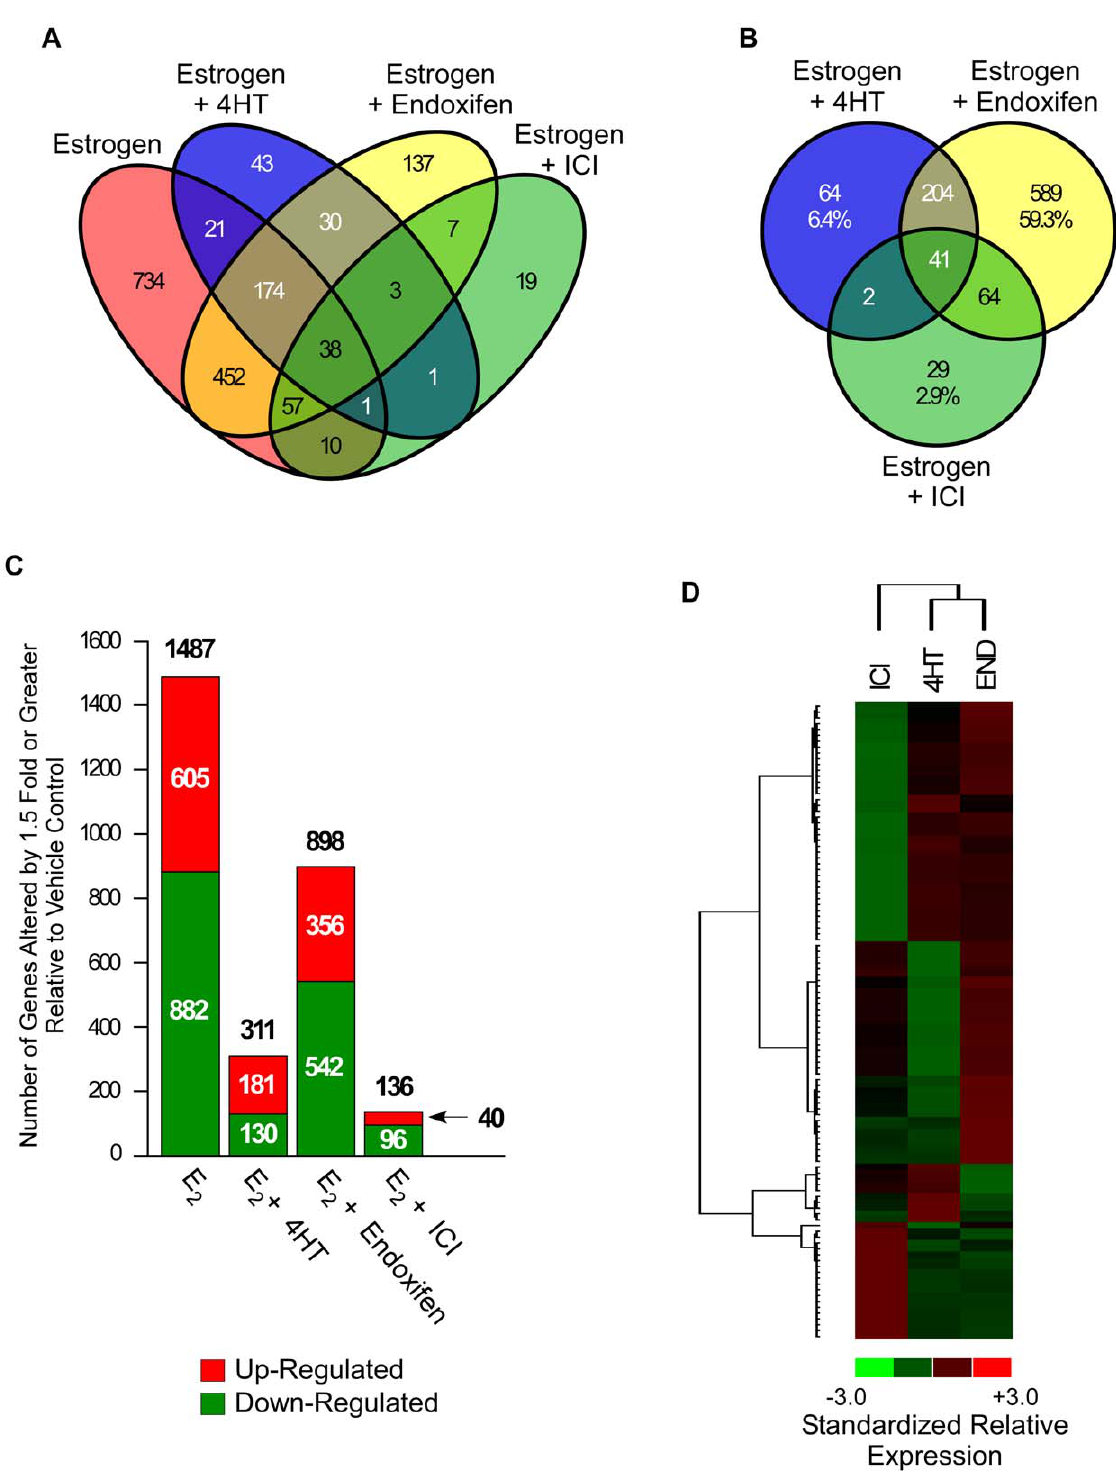
Figure 2. Microarray analysis of 4HT, endoxifen and ICI action in the presence of estrogen. ( A ) Venn diagram of genes whose expression levels were significantly altered by 1.5 fold or greater in MCF7 cells treated with 10 nM estrogen, or estrogen plus 100 nM concentrations of indicated anti-estrogens, relative to vehicle control treated cells following 24 hours of exposure. ( B ) Venn diagram of genes whose expression was altered by estrogen plus anti-estrogen treatments relative to vehicle treatment alone. ( C ) Graph depicting the number of genes up-regulated (red) and down- regulated (green) by indicated treatments relative to vehicle control treated cells. ( D ) Heat map depicting the hierarchical clustering of genes that were differentially expressed in at least one of the indicated treatment groups relative to vehicle control and which had average fold-changes . 3 standard deviations from all other genes in the comparison. Red indicates increased gene expression while green indicates decreased gene expression relative to vehicle treated controls.